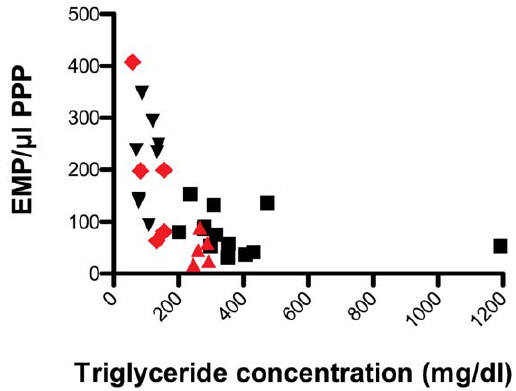
Figure 2. The inverse relation between EMP and TG after the in vitro administration of lipid-rich solutions to whole blood. Whole blood was taken from 8 healthy volunteers (black) and 5 patients with coronary heart disease (red). PPP was prepared from different aliquots to which lipid-rich solutions were added in different concentrations. EMP were detected by flow cytometry as particles , 1 m m and CD31 + /CD42b 2 , and TG concentration were determined in plasma. The figure shows EMP numbers/ m l PPP from samples without lipid-rich solutions (black inversed triangles for the healthy volunteers and red diamonds for the cardiovascular patients) and samples with added lipid-rich solutions in different concentrations (black quadrangles for the healthy volunteers and red triangles for the cardiovascular patients). Taken all samples together a non-linear inverse relation exists between TG concentration and the number of EMP (r= 2 0.707, p , 0.001). EMP=endothelial microparticles, PPP=platelet poor plasma, TG=triglycerides.